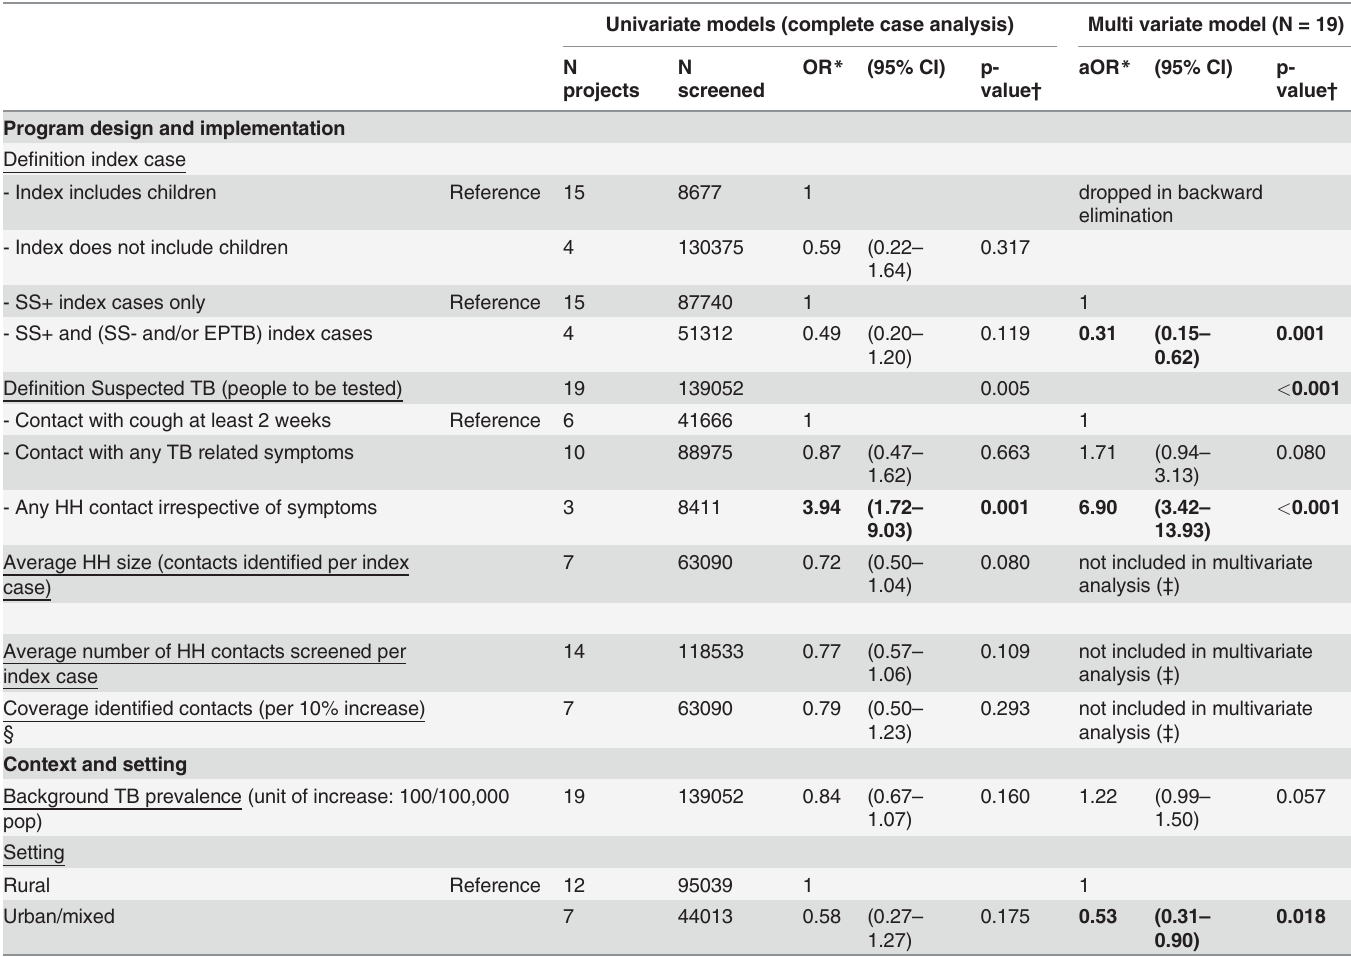
Table 3. Association between program design or contextual factors and the percentage yield of contact tracing using random effect, exact binomial logistic regression. Univariate models (complete case